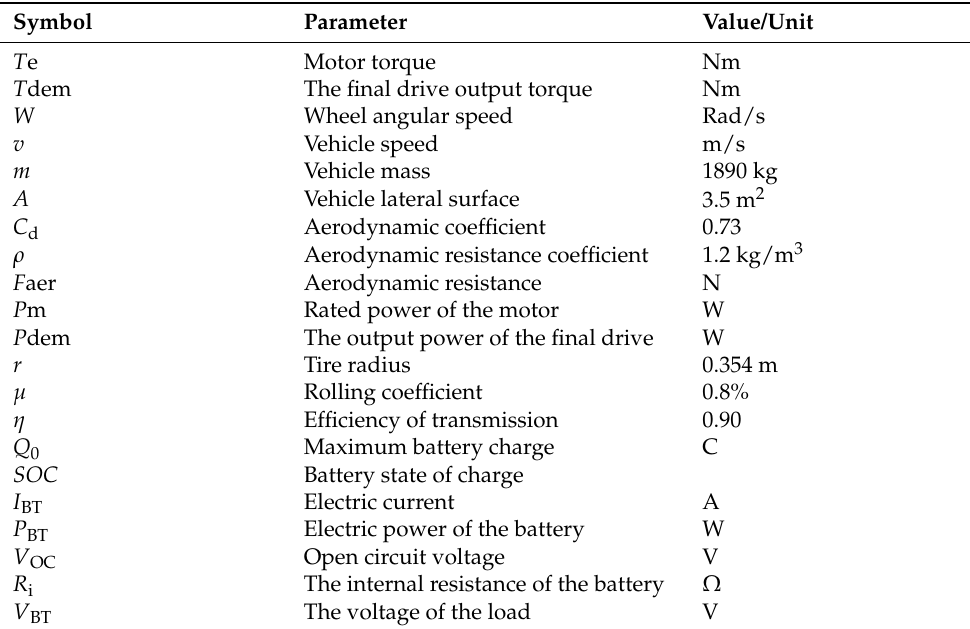
Table 1. Vehicle parameters